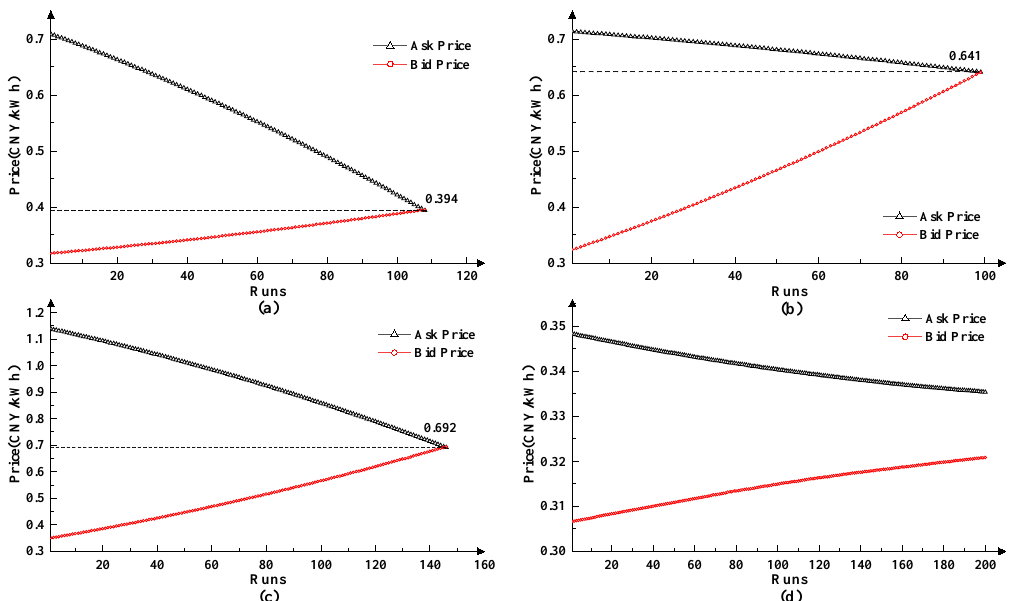
Figure 6. The bidding process of four rounds extracted from the proposed P2P energy trading process: a trade round between ( a ) microgrid (MG) 6(bid) and MG 9(ask) in time slot 12; ( b ) MG 5(bid) and MG 13(ask) in time slot 15; ( c ) MG 1(bid) and MG 14(ask) in time slot 22; ( d ) MG 4(bid) and MG 8(ask) in time slot